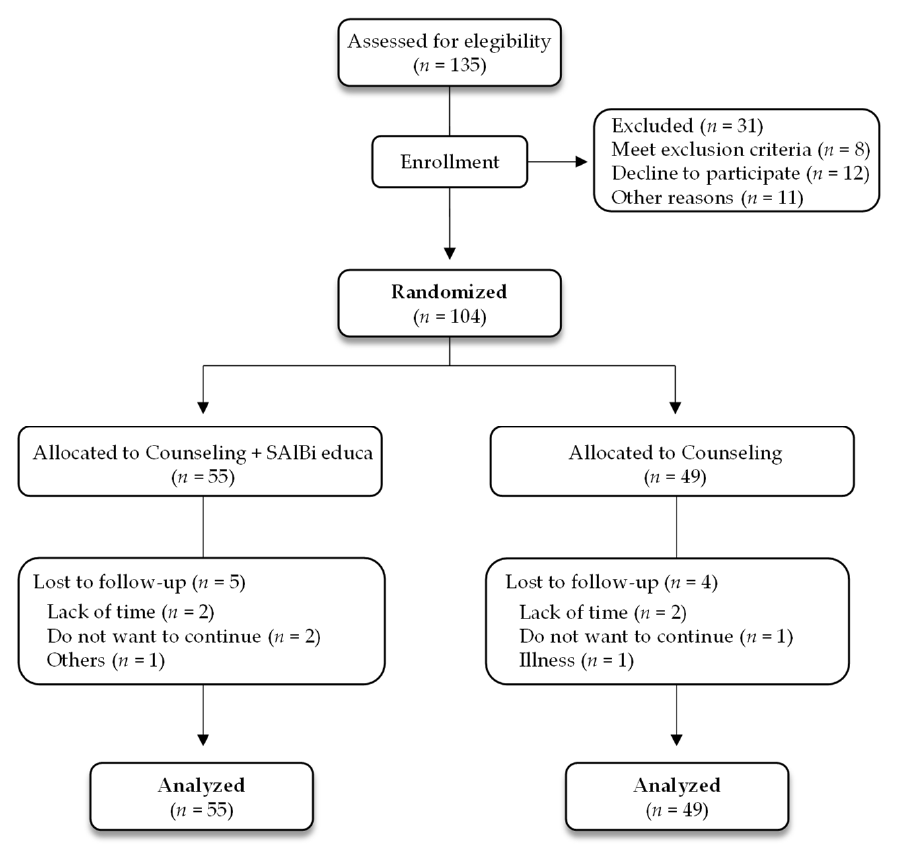
Figure 1. Study flowchart.